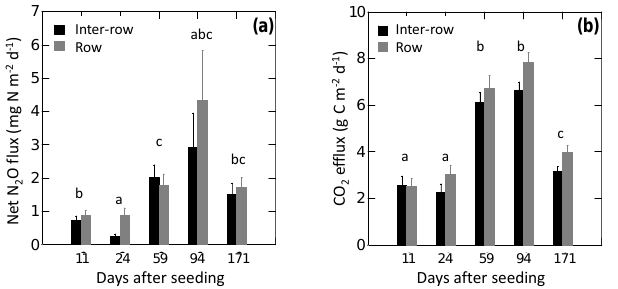
Figure 1. Mean (a) net N 2 O flux and (b) CO 2 efflux for all three transects ( n = 24 per sampling date except n = 16 on DAS 94) in inter-rows (black bars) and rows (grey bars). Error bars represent standard errors, and different letters indicate statistically significant differences among sampling dates.